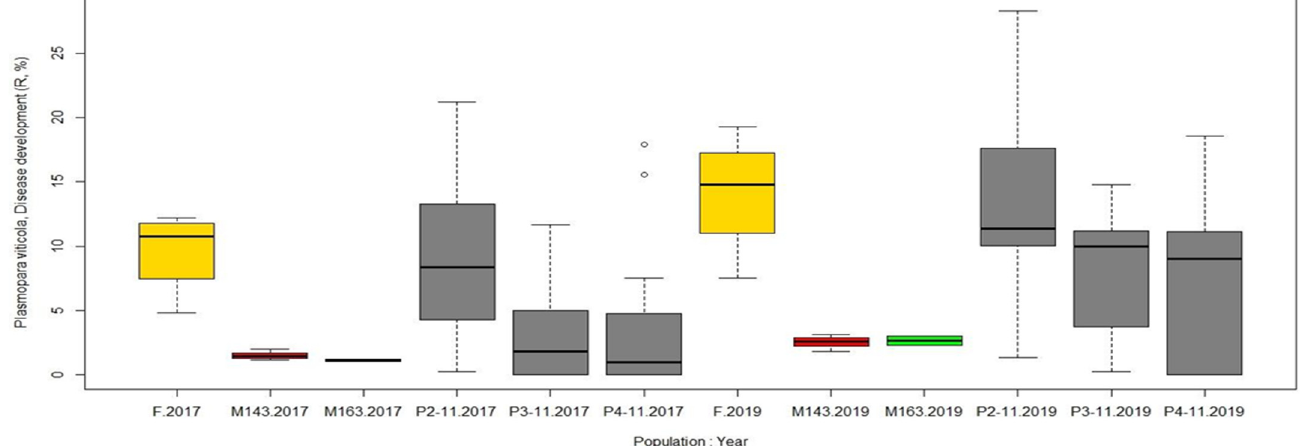
Figure 8. Resistance to downy mildew (assessed as disease development (R, %) per plant) of three hybrid populations (colored in dark gray) and their parental genotypes (female M. No. 31-77-10, in yellow; male 2000-305-143, in red; male 2000-305-163, in green) under field natural conditions recorded in 2017 and 2019.